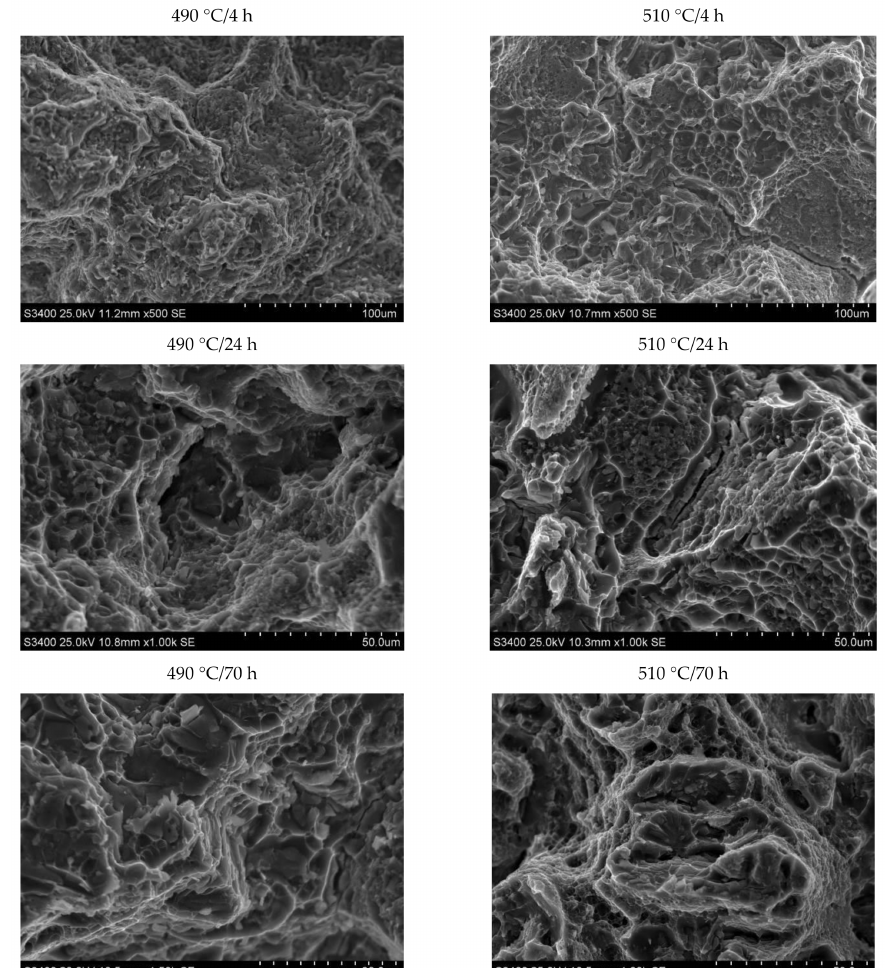
Figure 22. Images of fractures after precipitation strengthening and static tensile test.